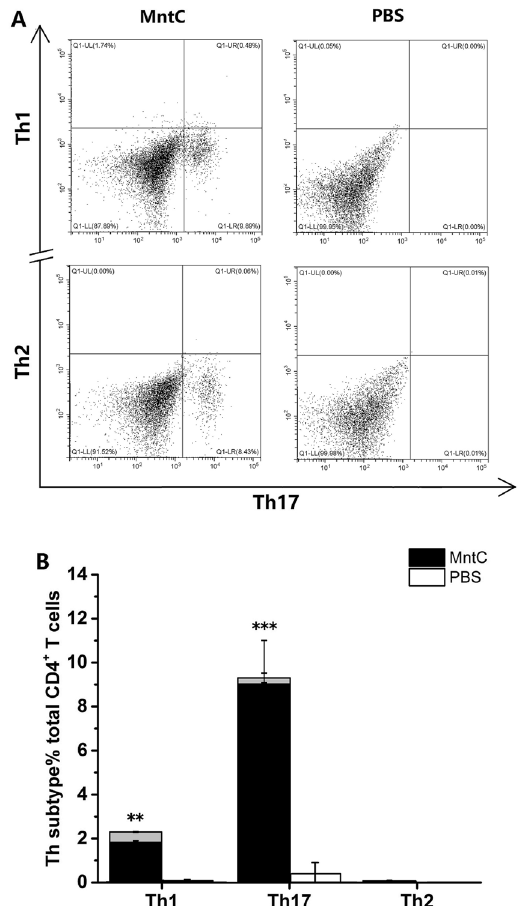
Figure 5. Phenotypic analysis of CD4 + T cells after immunization by MntC. ( A ) After 7 days’ incubation, lymphocytes were collected and treated with PMA, ionomycin and Golgistop for 6 hours. Then these cells were washed and stained with fluorescent antibody for Th1, Th17 and Th2, analyzing by flow cytometry. ( B ) Th1, Th17 and Th2 cell responses of all immunized mice were statistically analysed. The grey bars represent the proportion of double-positive cells. Significant differences were indicated by ( * P < 0.05), ( ** P < 0.01) and ( *** P <